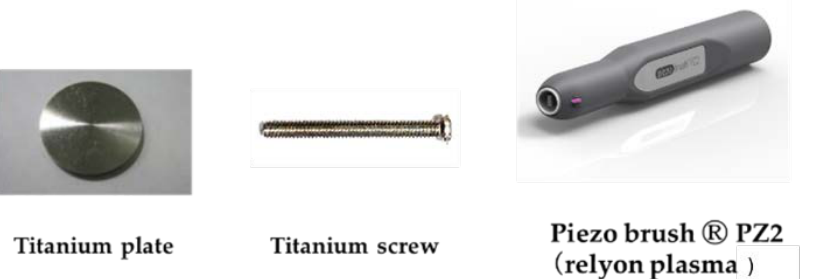
Figure 13. Titanium samples and titanium screw implants were used in this study for in vitro and in vivo analysis, respectively. The plasma treatments on the titanium surface were performed using a piezobrush ® PZ2.